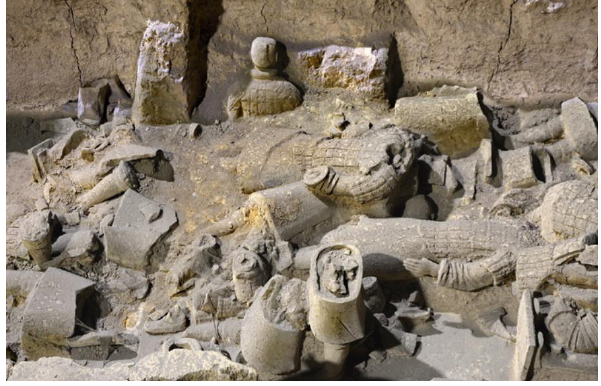
Figure 1. Some unearthed Terracotta Warrior